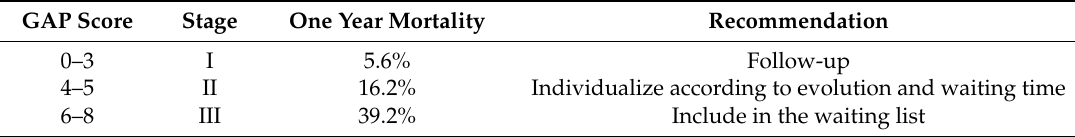
Table 3. Gender, age, physiology (GAP) index for the transplant